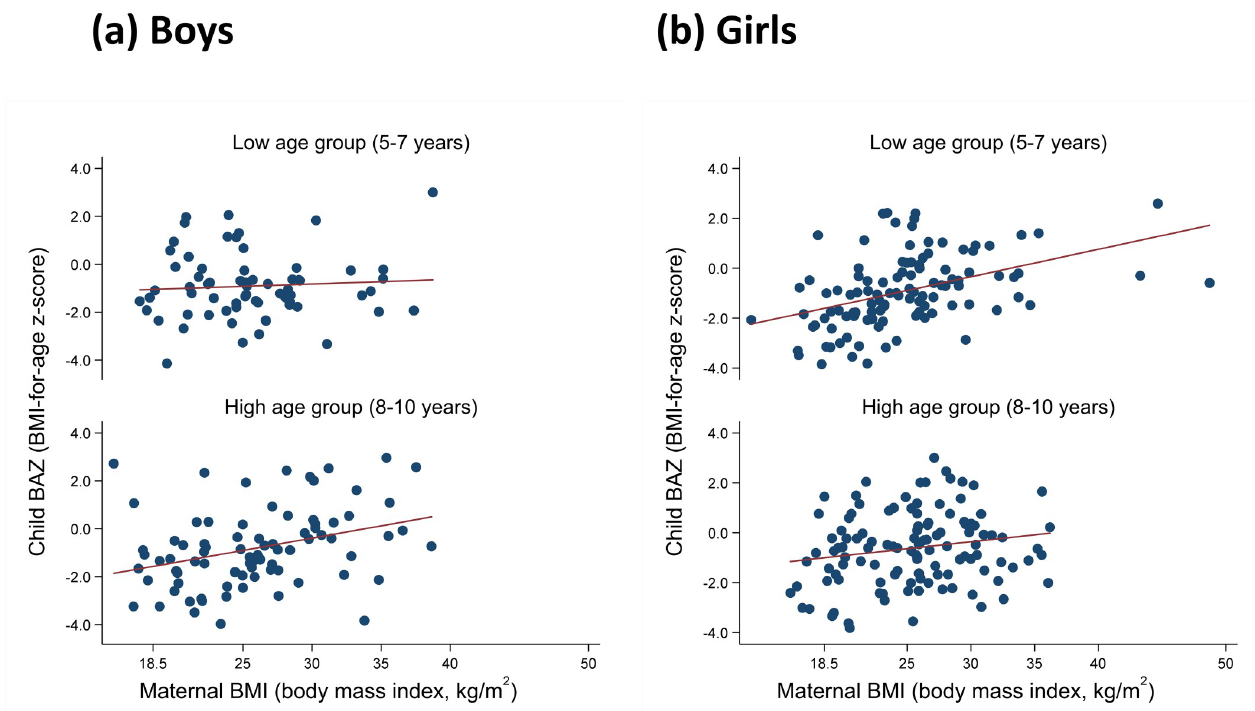
Fig 2. Distribution of maternal body mass index (BMI) and child BMI for age z-score (BAZ) according to sex and age group (low: 5–7 years old, high: 8–10 years old). (A) Boys: Low, r = 0.02, p = 0.90; High: r = 0.39, p < 0.001. (B) Girls: Low, r = 0.51, p < 0.001; High, r = 0.18, p = 0.06.